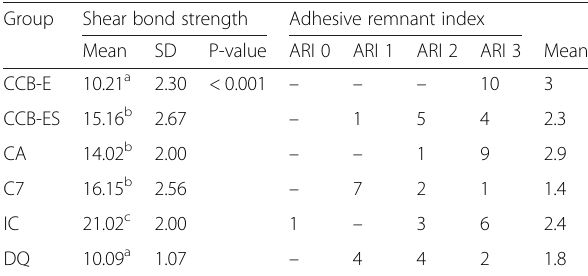
Table 3 Shear bond strength values and adhesive remnant index scores of all tests groups Group Shear bond strength Adhesive remnant